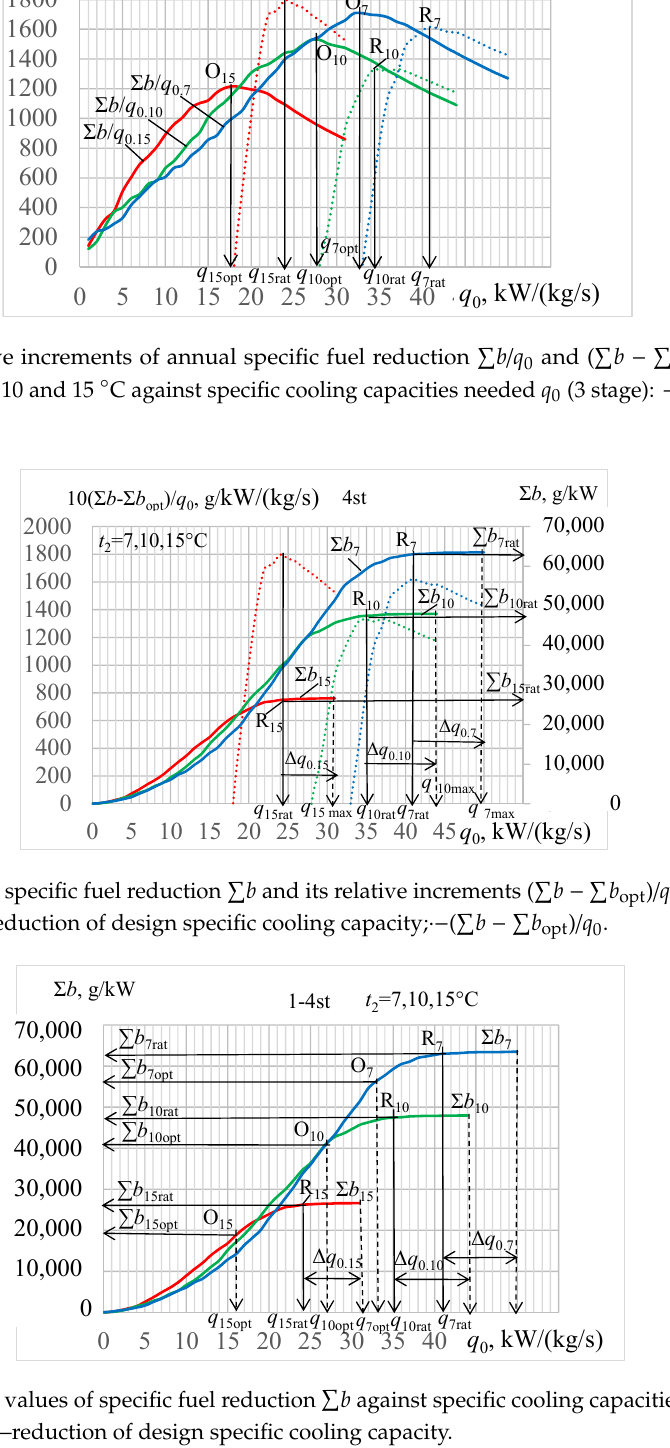
(cid:80) Figure 14. Annual values of specific fuel reduction ∑ b against specific cooling capacities q 0 for t a 2 = 7, b against specific cooling capacities q 0 for t a 2 = 7, Figure 14. Annual values of specific fuel reduction 10 and 15 °C: Δ q 0 — reduction of design specific cooling capacity. 10 and 15 ◦ C: ∆ q 0 —reduction of design specific cooling